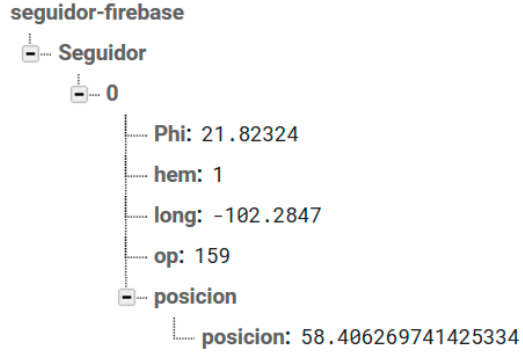
Figure 9. JSON data structure.